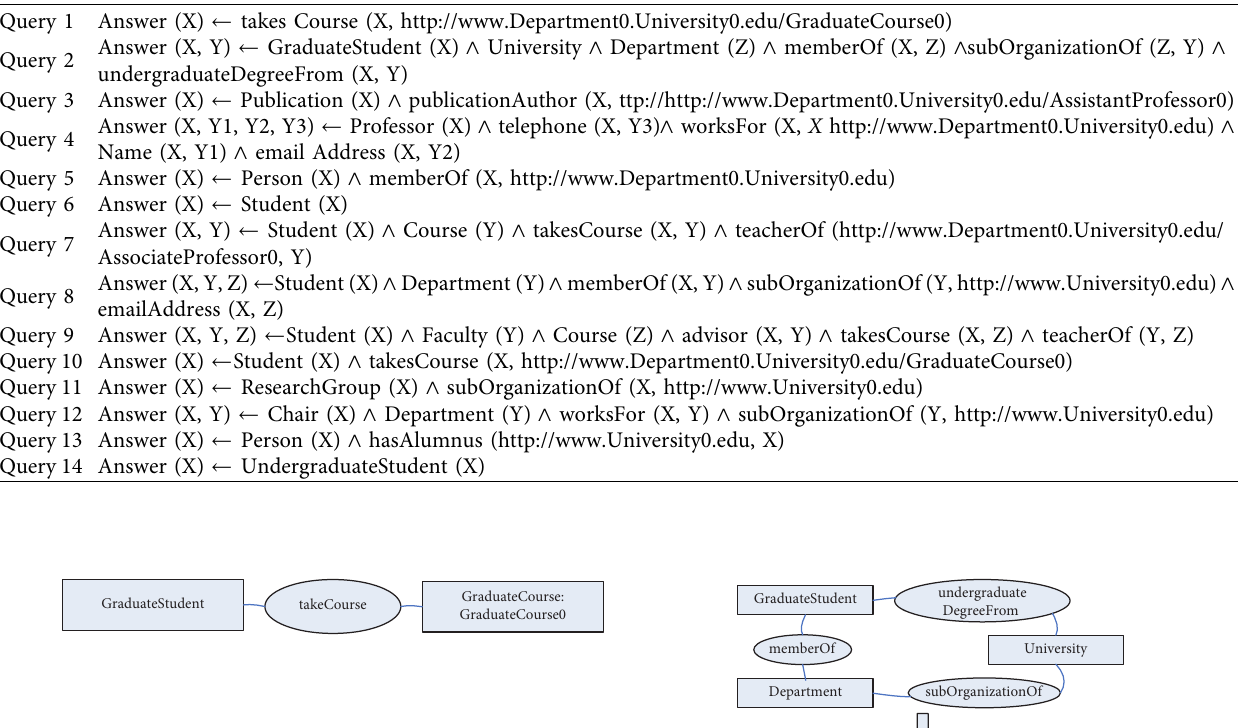
Table 4: Queries used in the